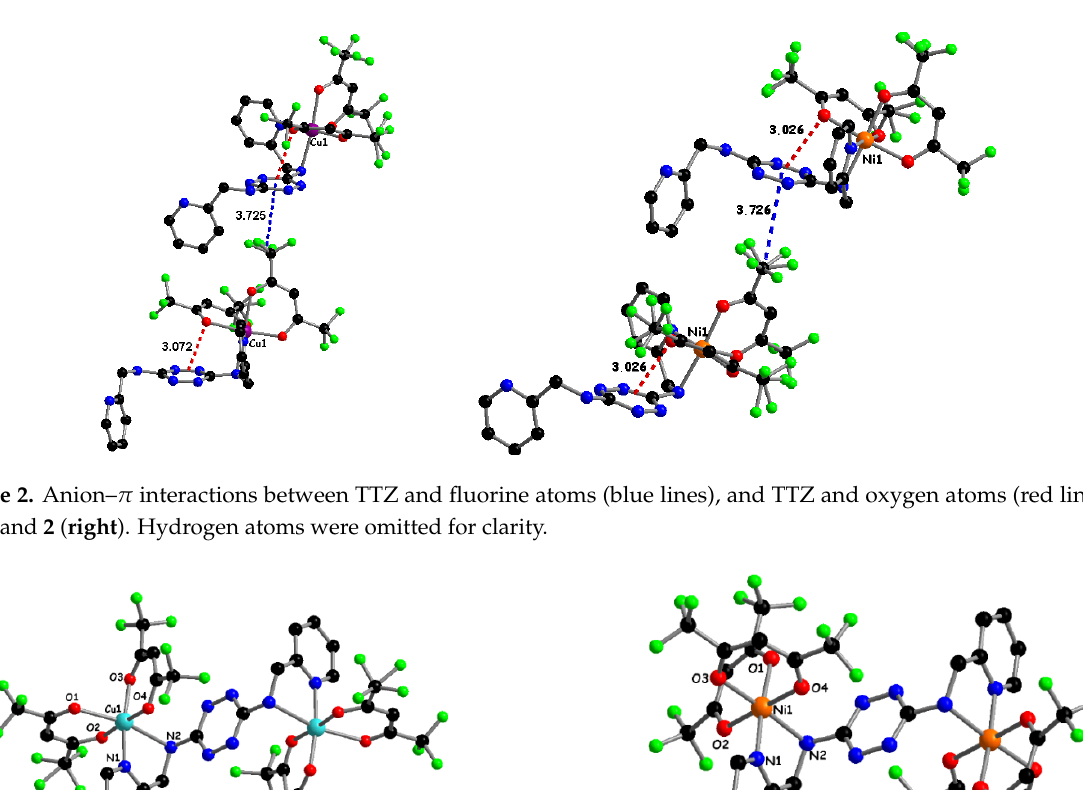
Figure 3. Crystal structures of 3 ( left ) and 4 ( right ) together with a partial atom numbering scheme. Hydrogen atoms and solvent molecules were omitted for clarity.